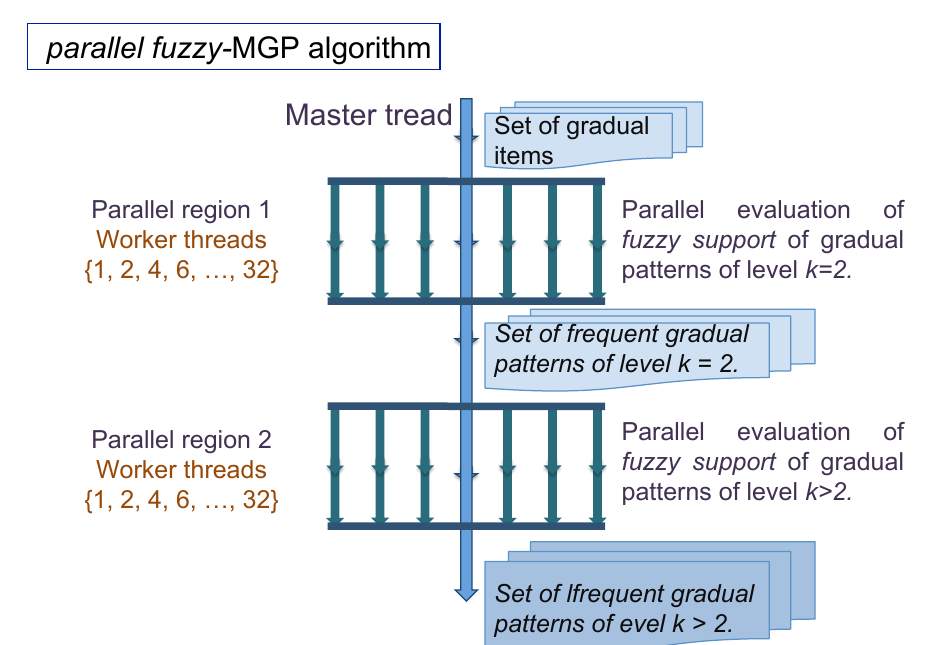
Figure 5. Parallel extraction of gradual patterns